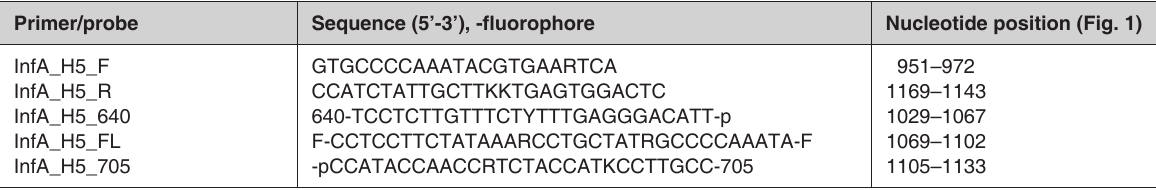
TABLE 1 Primers and probes used to differentiate between HPAI and LPAI in this study a